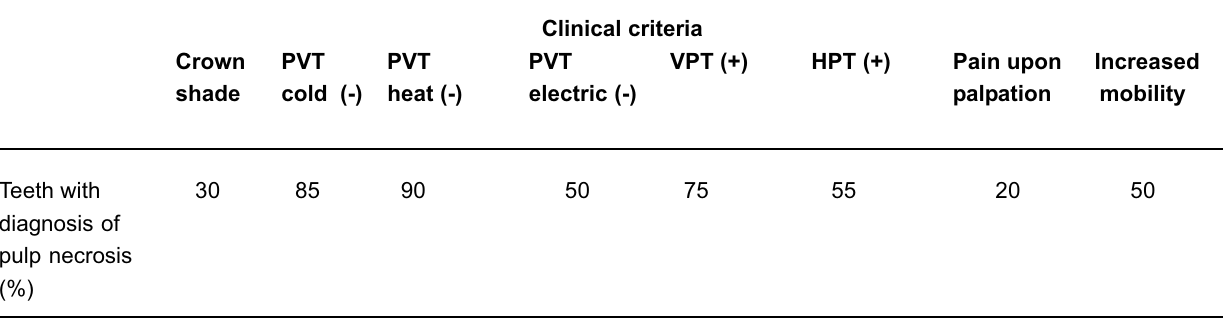
(-): negative response; (+): positive response; PVT: pulp vitality test; VPT: vertical percussion test; HPT: horizontal percussion test.